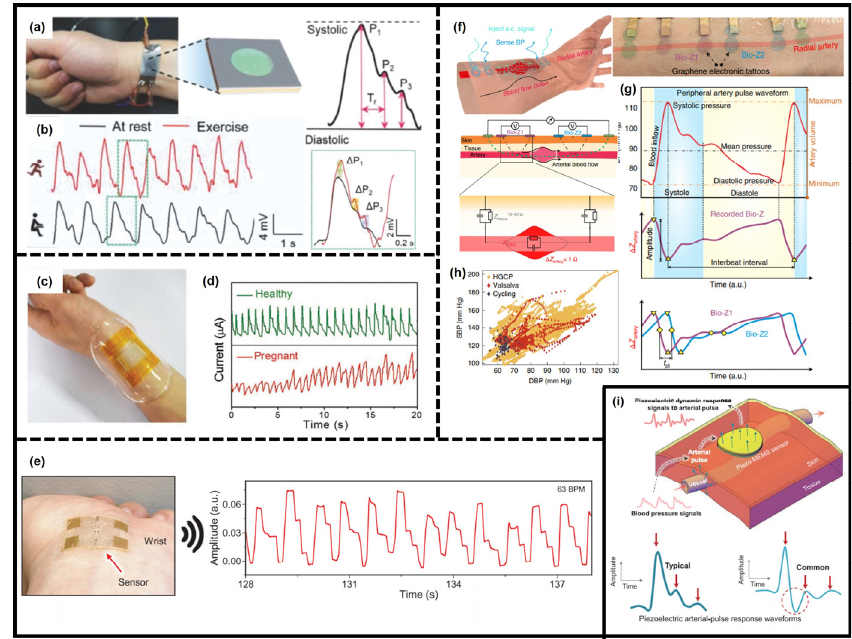
Figure 7. The wearable systems applied in arterial pulse pressure monitoring. ( a ) Photograph of a patchable sensor attached on a wrist to measure the radial artery ( left ) and three typical types in radial artery measurements. ( b ) Two characteristic signals before and after exercise and magnified curve of pulse wave signal of heart rate and type of blood pressure. Reproduced with permission from ref. [216]. Copyright 2018 Wiley-VCH. ( c ) Photograph of a device for detection of wrist pulses and ( d ) original wrist pulses signals of a non-pregnant person and a pregnant woman. Reproduced with permission from ref. [63]. Copyright 2014 Wiley-VCH. ( e ) A wireless pulse measurement using GaN SAW wearable system. Reproduced with permission from ref. [38]. Copyright 2021 American Association for the Advancement of Science. ( f ) Illustration of bioimpedance blood pressure measurement. ( g ) Correlation between arterial blood pressure and bioimpedance. ( h ) Recognition performance of bioimpedance-monitoring system. Reproduced with permission from ref. [218]. Copyright 2022 Nature Publishing Group. ( i ) Illustration of piezoelectric dynamic response to arterial pulse and typical waveform. Reproduced with permission from ref. [219]. Copyright 2022